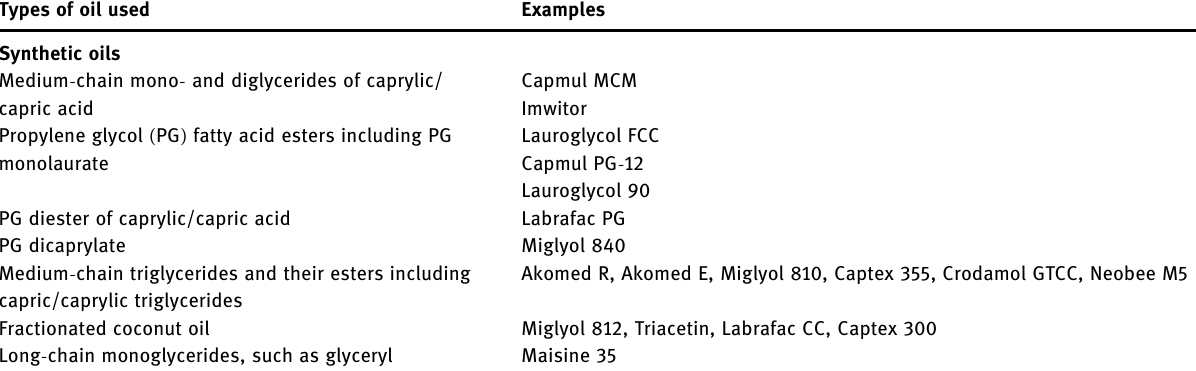
Table 2: Synthetic and natural oils used for the formulation of NLCs and their examples Types of oil